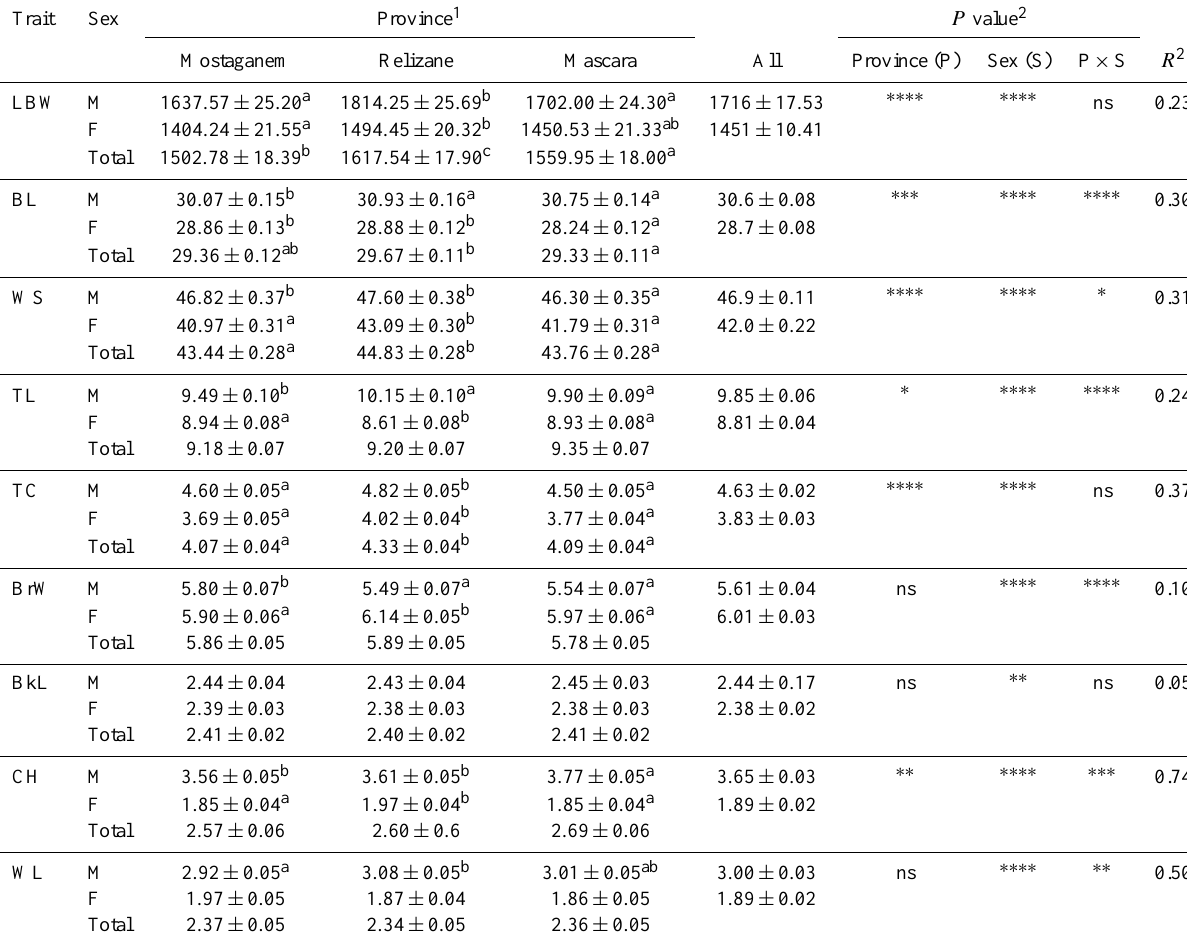
Table 4. Least-squares means (LSM ± SE) of province and sex effect for live body weight (g) and eight linear measurements (cm) of 778 local chickens from the northwest of Algeria (Mostaganem: males = 106, females = 145; Relizane: males = 102, females = 163; Mascara: males = 114, females = 148). Explanations on trait abbreviations can be found in Sect. 2.3.